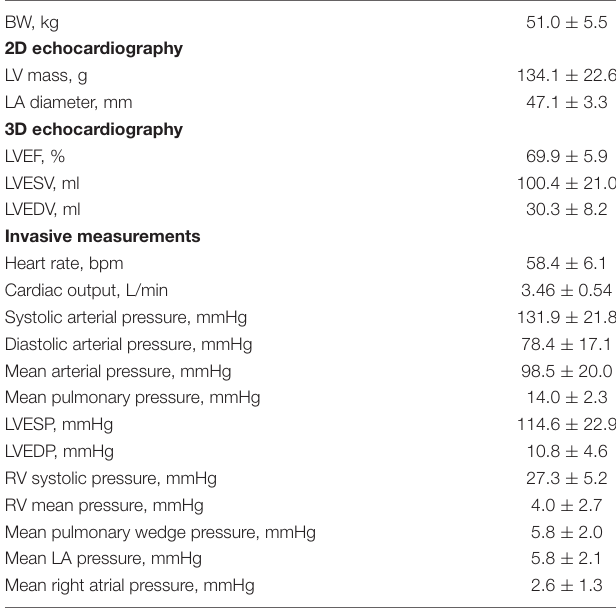
TABLE 1 | Baseline characteristics of experimental